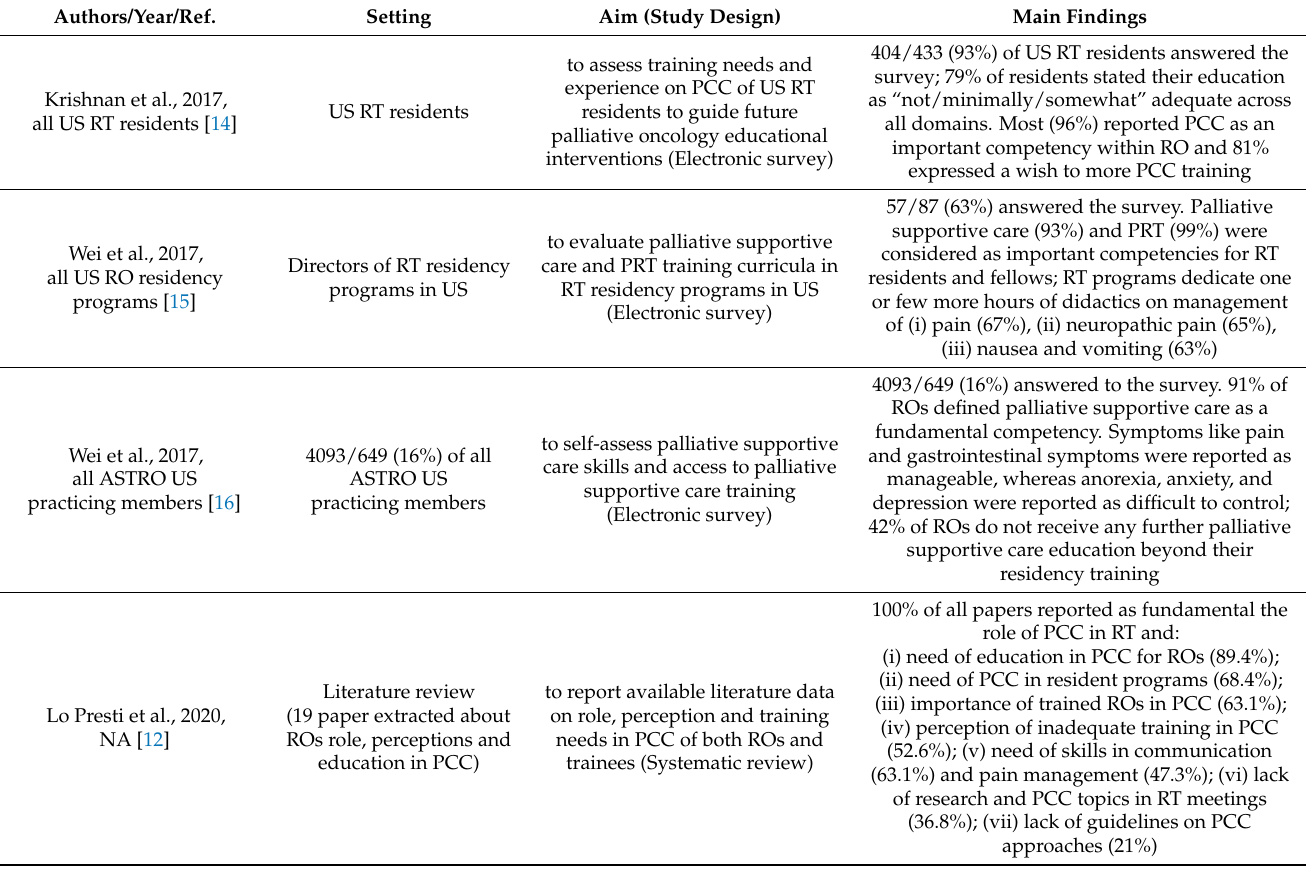
Table 5. Characteristics and main findings on studies about education and training of radiation